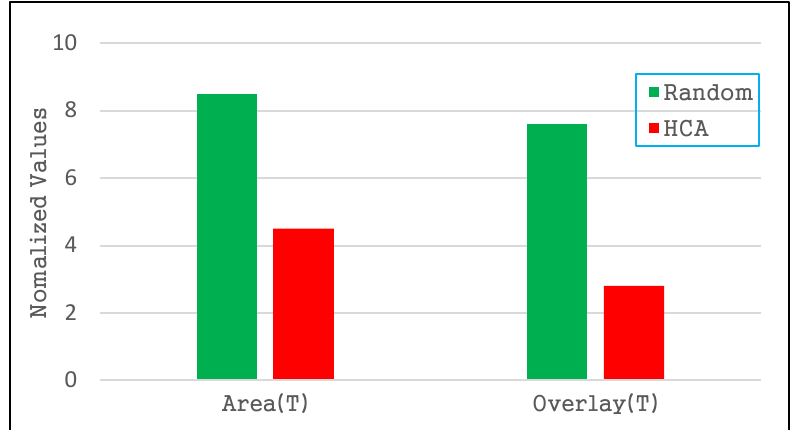
Figure 10. The index quality comparison of the R-tree based on random and HCA.